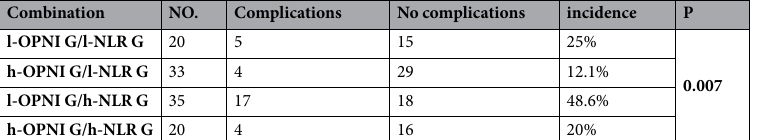
Table 9. Correlation analysis of OPNI and NLR.